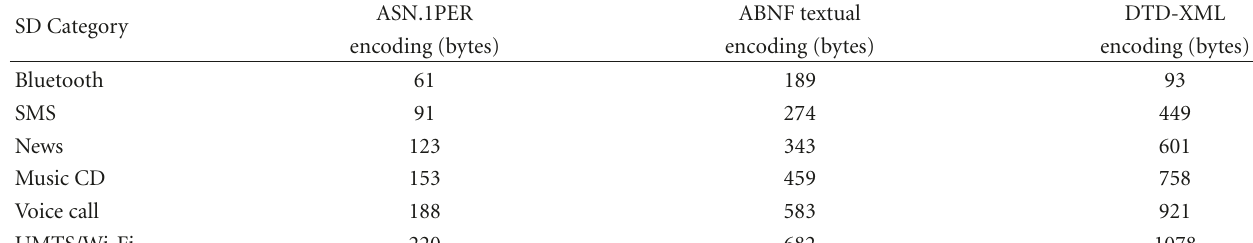
Table 1: SD sizes in di ff erent formats.